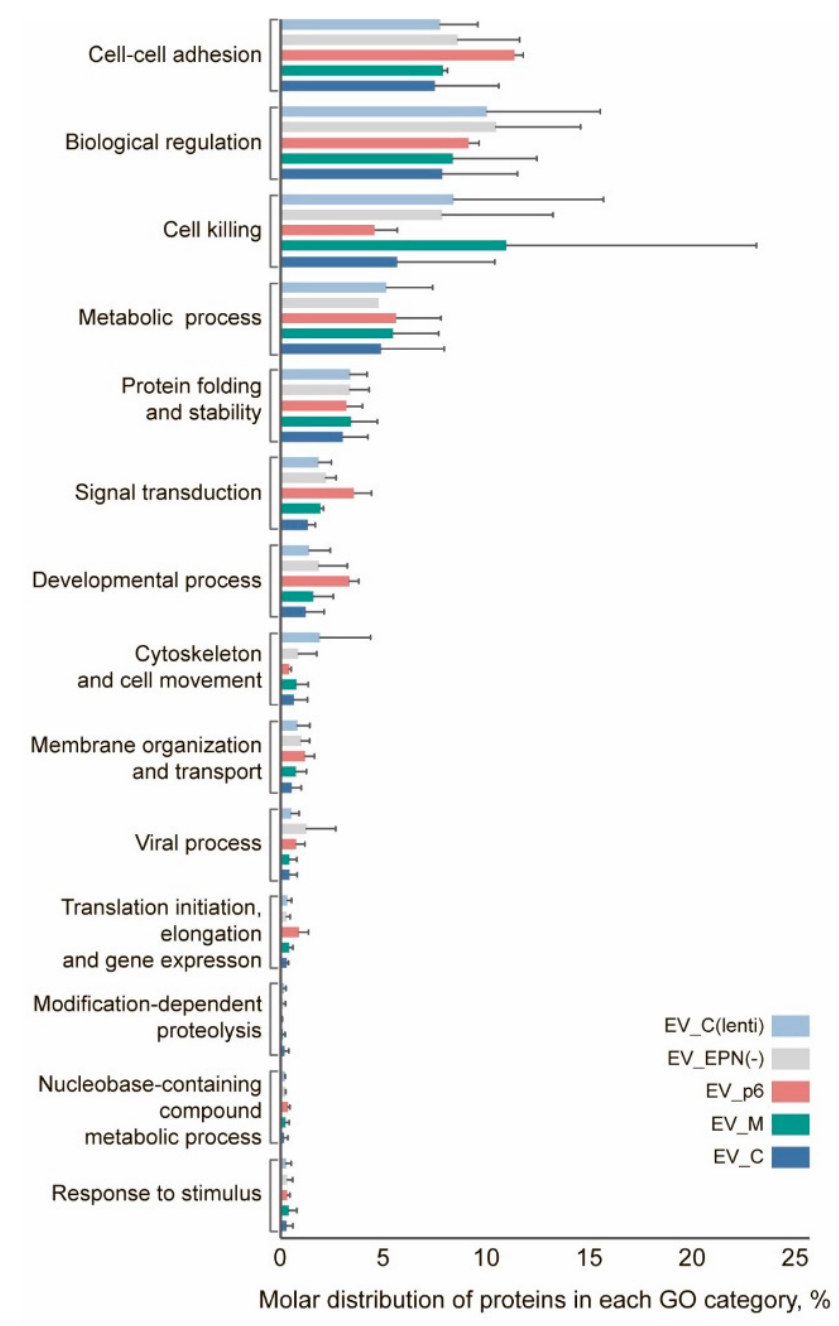
Figure 8. Gene ontology enrichment analysis of the EV proteins identified using the DAVID database. No significant differences among EV samples were found as determined by two-way ANOVA.